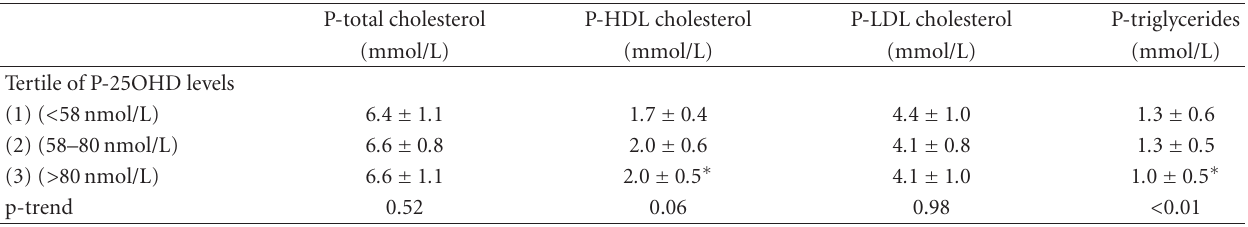
Table 2: Indices of cholesterol status by tertiles of plasma 25-hydroxyvitamin D (P-25OHD) levels at baseline (mean ±